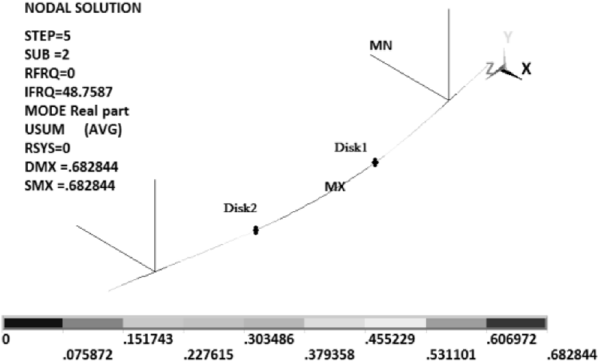
Fig. 2. The fi rst order mode shape of the